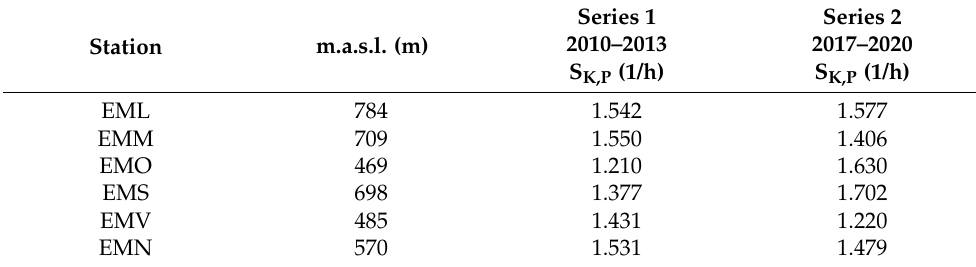
Table 2. It presents the entropies of the pollutants (Ps) in the two periods of the study (2010–2013 and